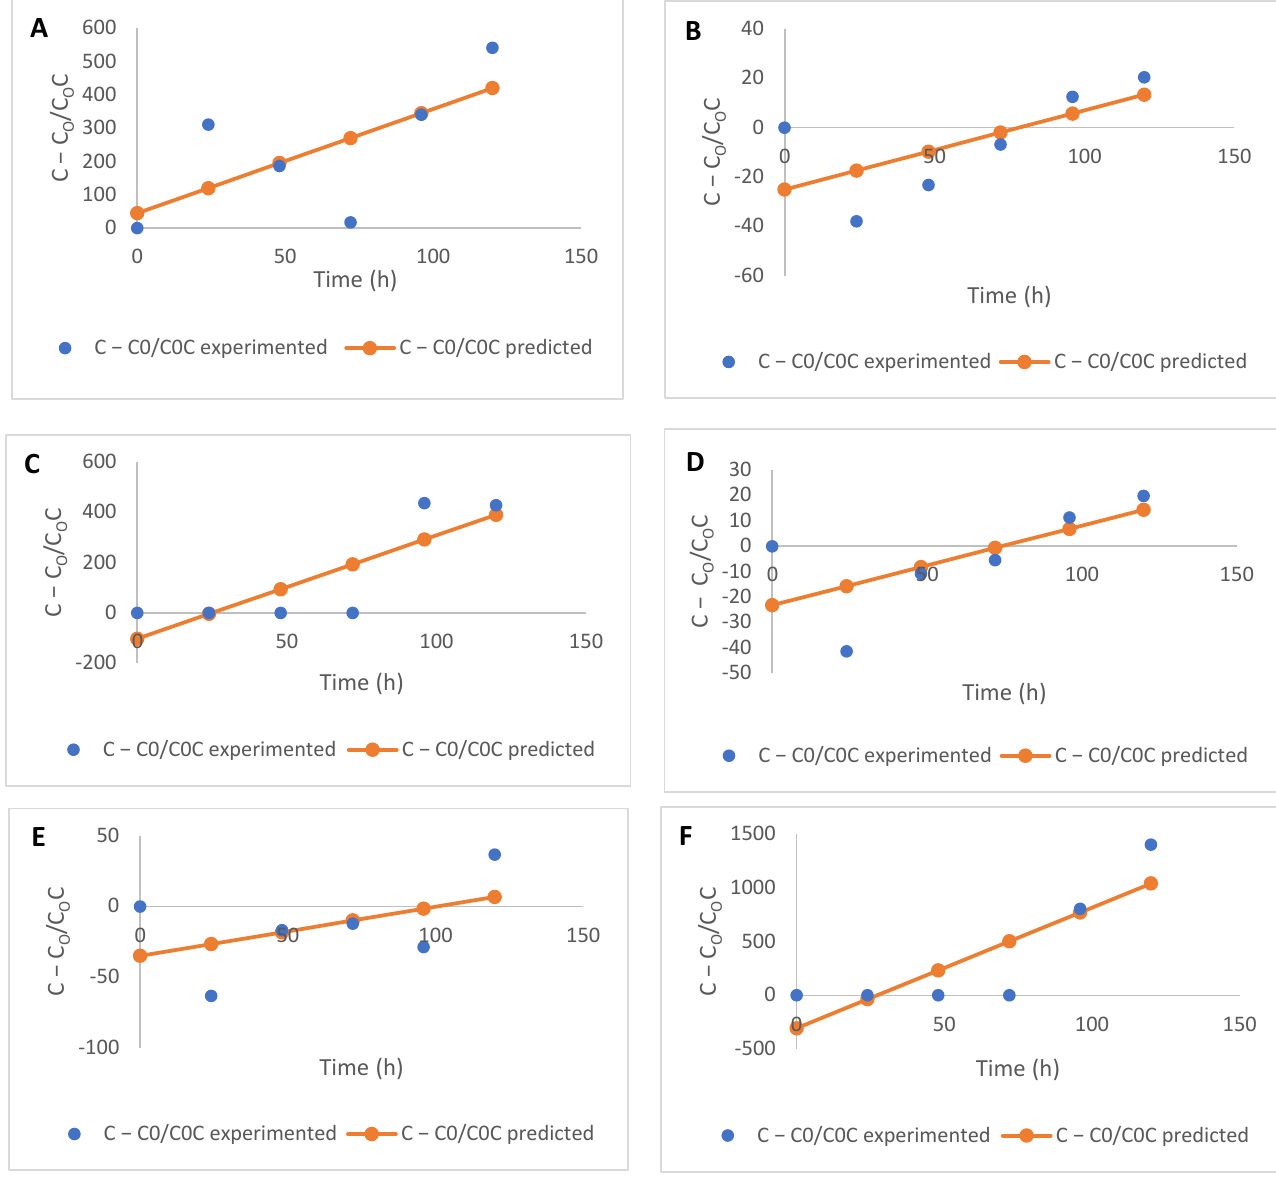
Figure 5. Kinetics (second-order) of free phenolic acid degradation during the fermentation of maize flour ( A ) caffeic acid, ( B ) ferulic acid, ( C ) gallic acid, ( D ) p -coumaric acid, ( E ) sinapic acid, and ( F ) vanillic acid.